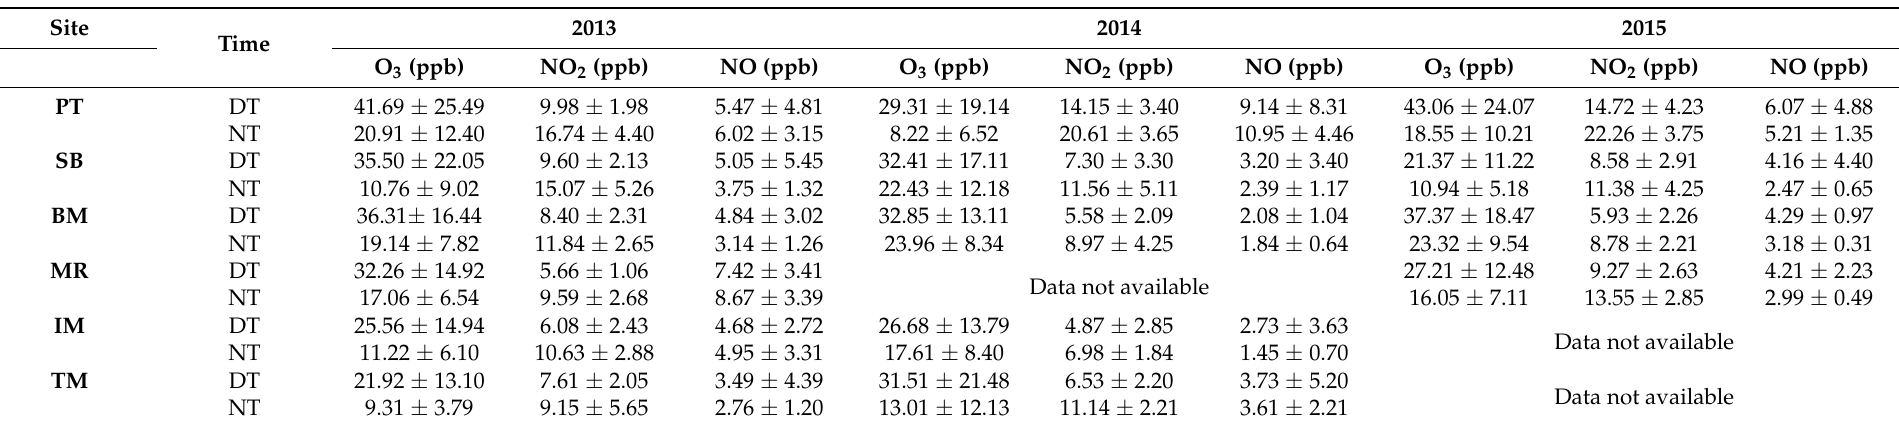
Table 3. Descriptive statistics of O 3 , NO 2, and NO at different sites (mean ± standard